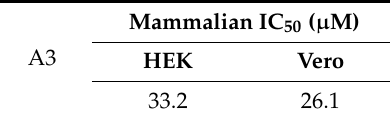
Table 8. IC 50 values for A3 on HEK and Vero mammalian cell lines. Results represent triplicates.